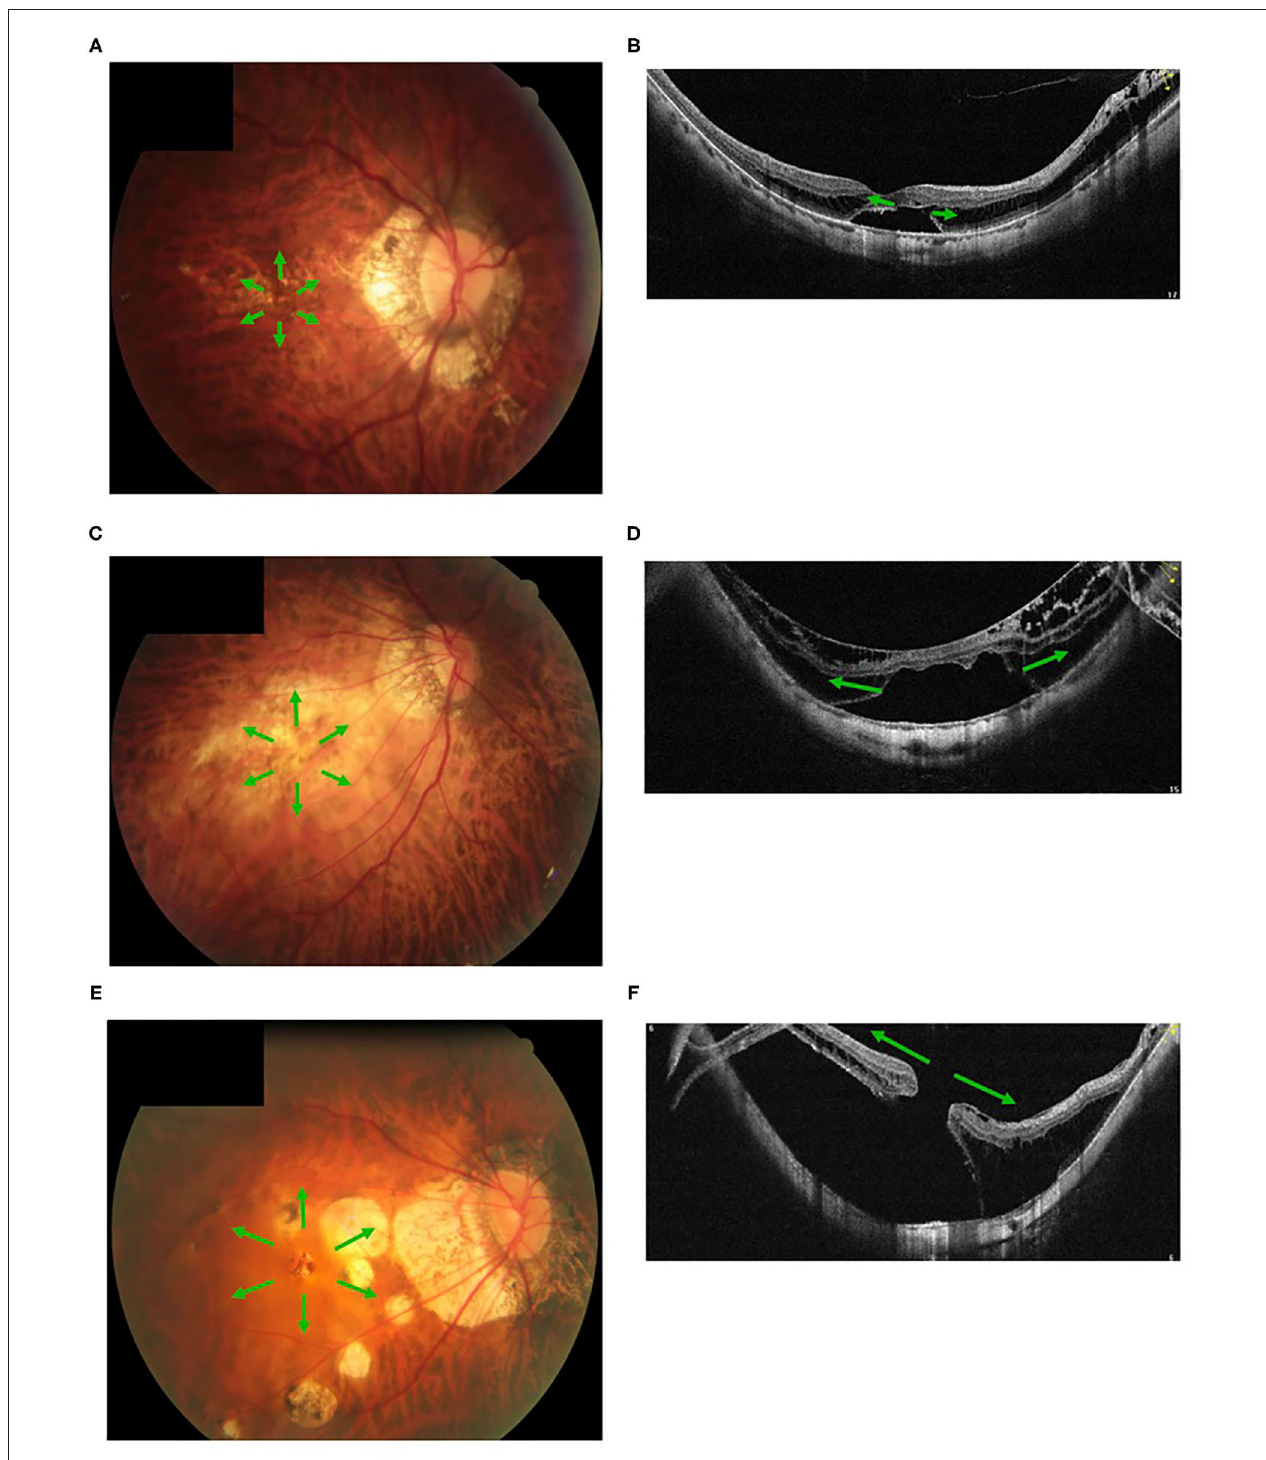
FIGURE 5 | Fundus images with different myopic atrophy maculopathy grades and corresponding myopic tractional maculopathy in optical coherence tomography. A patient with mild diffuse chorioretinal atrophy (A) presented with a small outer lamellar macular hole and foveal detachment (B) . A patient with more serious diffuse chorioretinal atrophy (C) presented with a large outer lamellar macular hole and foveal detachment (D) . A patient with patchy chorioretinal atrophy (E) presented with a full-thickness macular hole and retinal detachment (F) . Green arrow, the tangential traction on the macular might facilitate a lamellar macular hole into a full-thickness macular